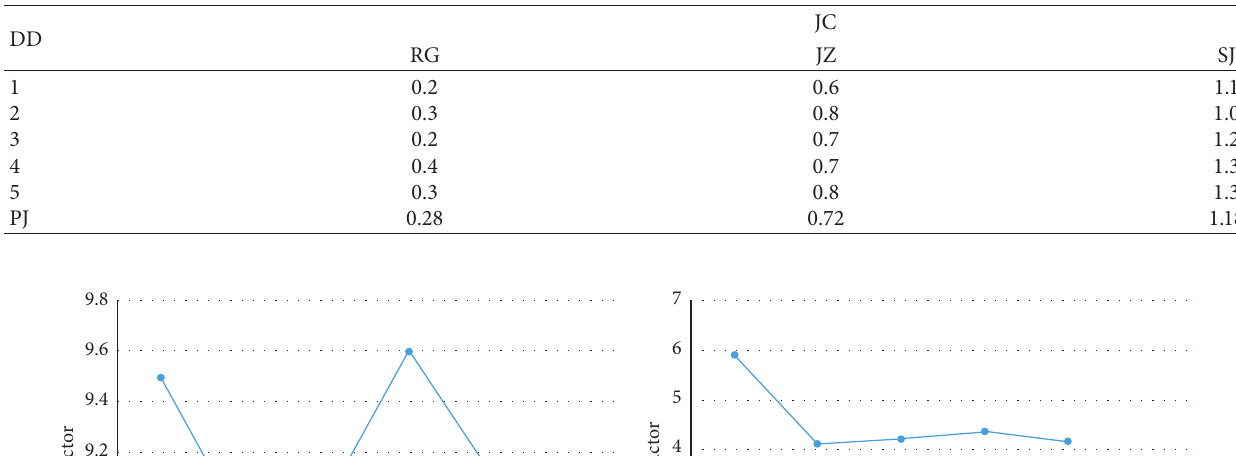
Table 1: Monitoring time of three different algorithms.